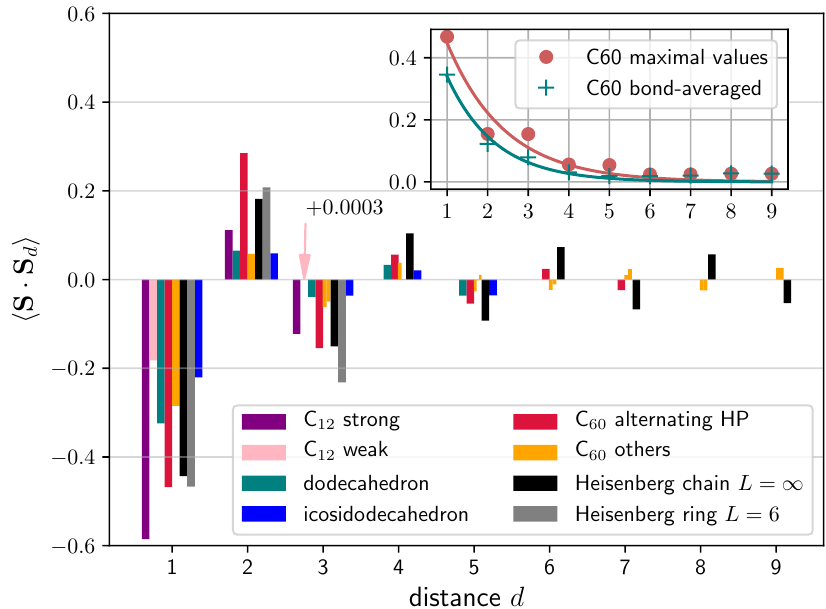
Figure 5: Comparison of the spin-spin correlation function between different ge- ometries: analytical values for the infinite Heisenberg chain [ 46 ] , numerically exact values for the L = 6 Heisenberg ring, C (truncated tetrahedron) and the dodec- 12 ahedron [ 26 ] . The icosidodecahedron values are according to our own DMRG cal- culation. The C alternating HP bonds are formed by alternating jumps along H 60 and P (cf. Fig. 3), starting with H; and link two sites within a hexagon up to d = 3. Note that the icosidodecahedron has two inequivalent bonds for d = 2,3,4, but the correlation along the second-type bond is very small and is omitted. The weak bond for C at d = 3 is + 0.0003 and thus barely visible. The inset shows an exponential 12 fit for the distance dependence of the C spin-spin correlations, either by taking the 60 maximal values for each d or by taking bond-averaged